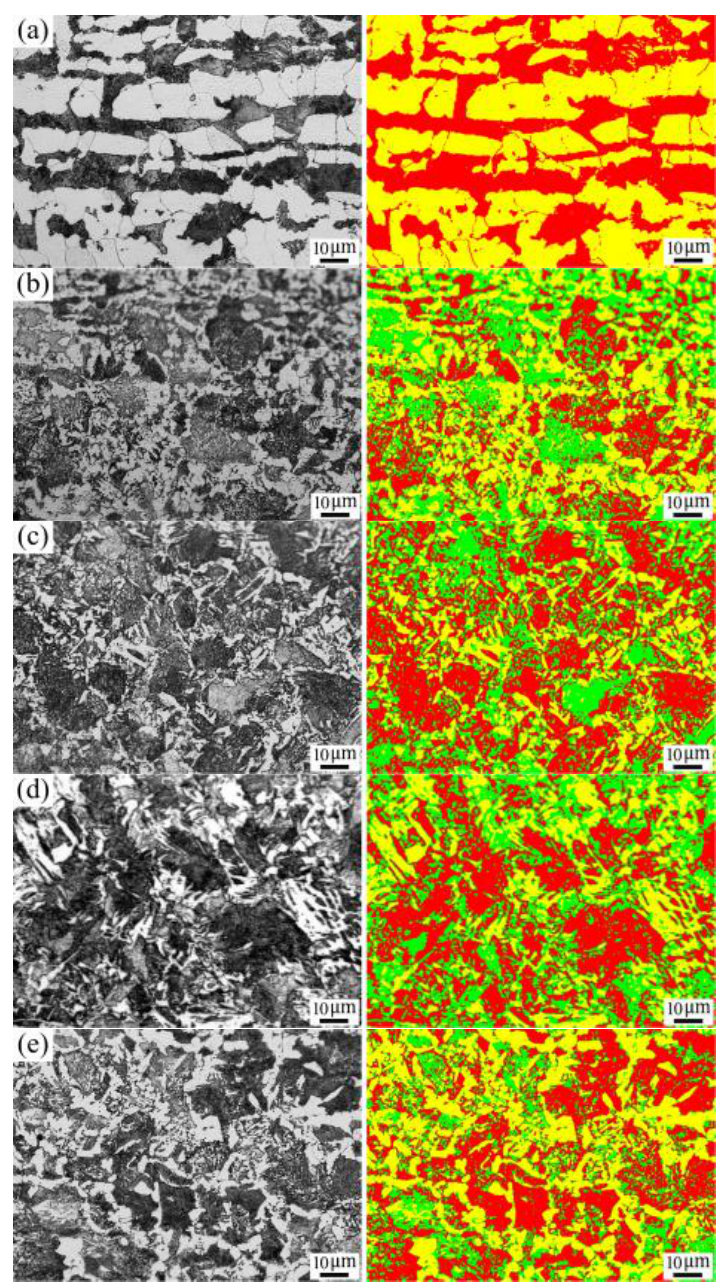
Figure 9. Microstructure and compositions of base metal of steel pipes ( a ) P1#; ( b ) P2#; ( c ) P3#; ( d ) P4#; and ( e ) P5#.